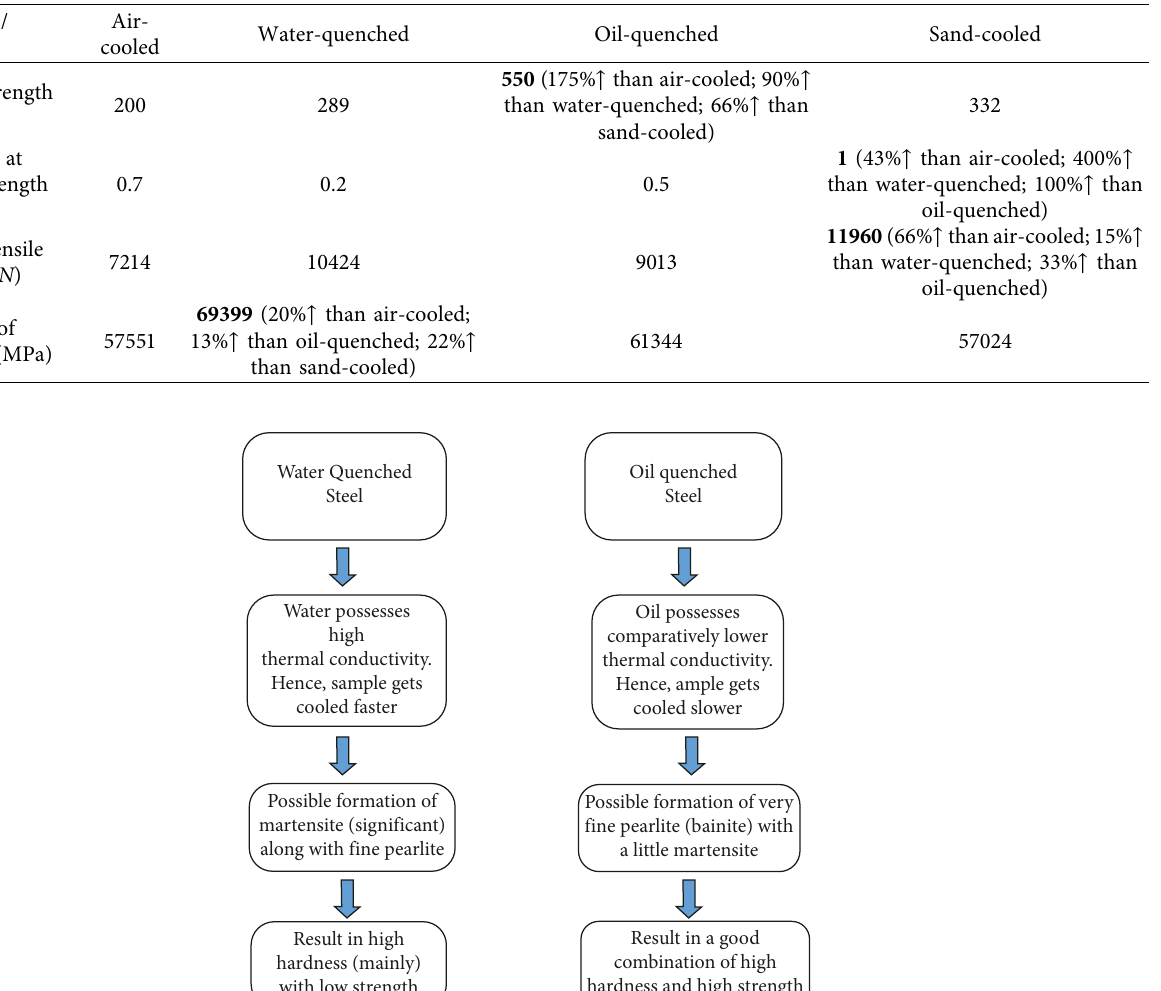
Table 3: Different parameters corresponding to tensile test.